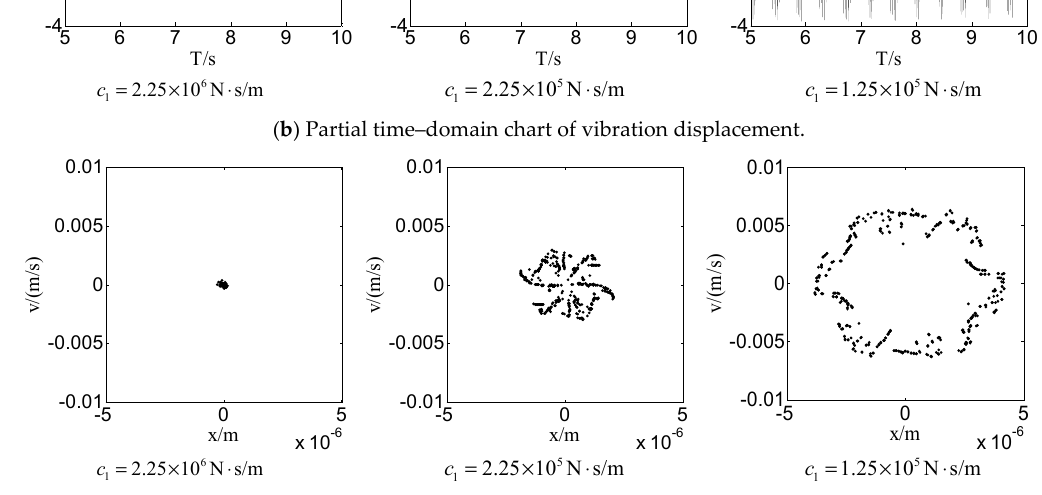
( c ) Phase diagram of vibration displacement and speed. Figure 4. E ff ect of equivalent damping on hydraulic cylinder vibration response. Figure 4. Effect of equivalent damping on hydraulic cylinder vibration response.